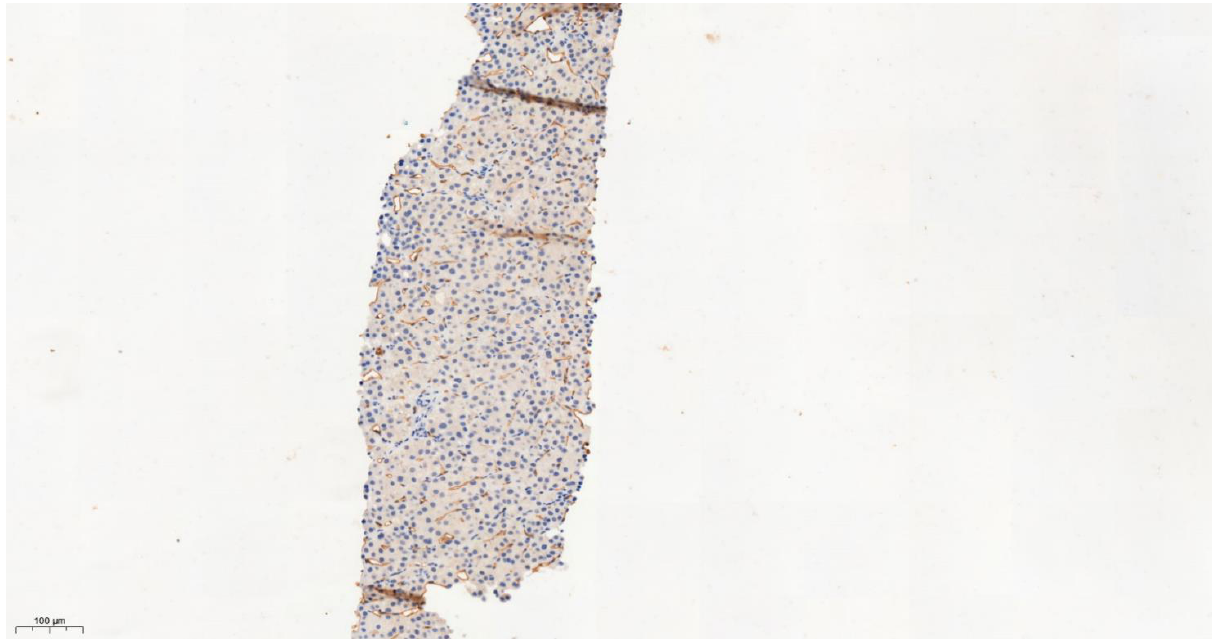
Figure 6. IHC characteristics of meprin A subunit a (MEP1A) in HCC at low power magnification (X10). The brown chromogen should indicate protein expression of MEP1A in the nucleus and cytoplasm of the hepatic and stromal cells. The slide section shows compact sheets and nests with thickened hepatocyte plates with mild cytological atypia in keeping with well differentiated hepatocellular carcinoma; staining for MEP1A here was negative (Allred score 0).